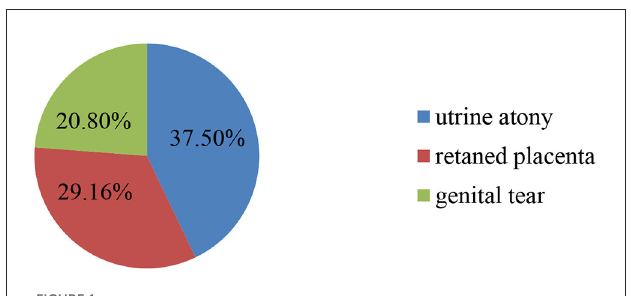
FIGURE1 Causes of PPH in women who give birth in the district areas health centers of Gedeo Zone, Southern Ethiopia, 2021 ( N = 577).